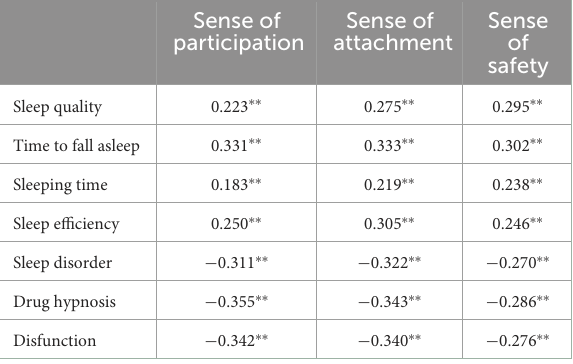
TABLE 6 Pearson correlation results of social environment and